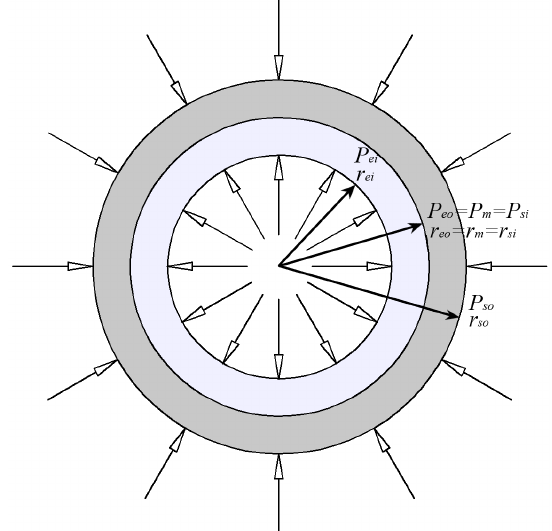
Figure 2. Cross-section of simplified DSOF motor stator model subjected to both internal and external